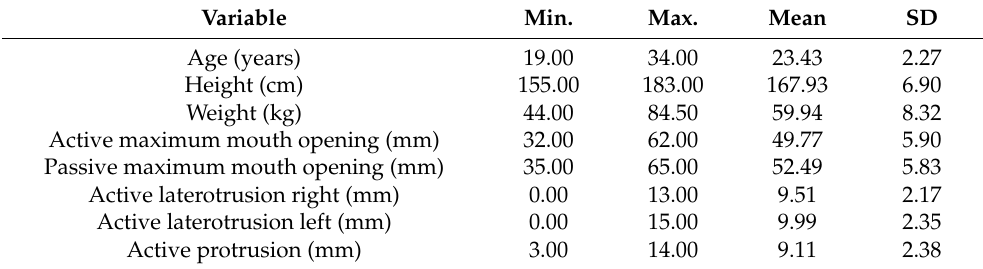
Table 1. Participants’ general characteristics, including age, height, weight, and mandibular range of